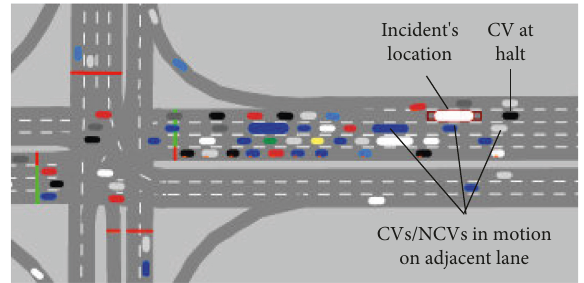
Figure 2: Vehicles’ movements and positions during an